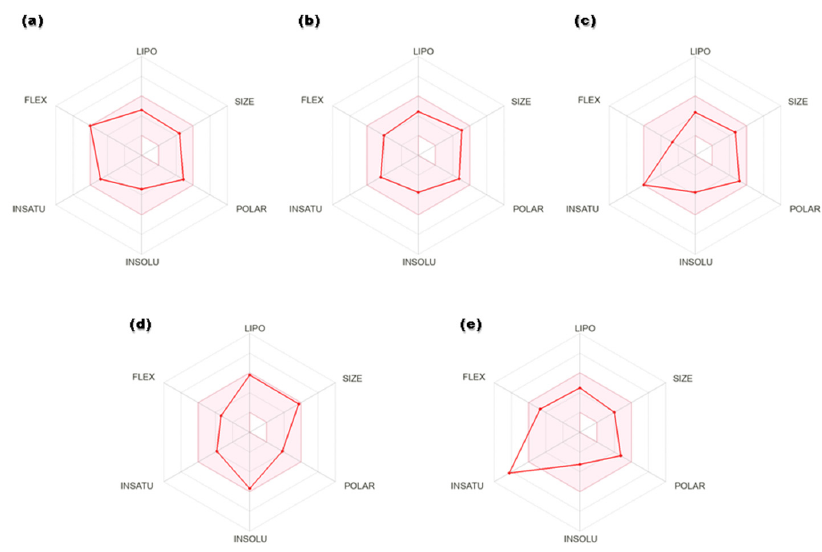
Figure 4. Radar plots of hits: ( a ) secoisolariciresinol, ( b ) syringaresinol, ( c ) cleomiscosin A, ( d ) tubu- losine and ( e ) terrestriamide. Colored area represents suitable oral bioavailability space. Pink color: suitable bioavailability area; red color: compound bioavailability area. Table 2. Results of compounds examined for Lipinski’s rule.